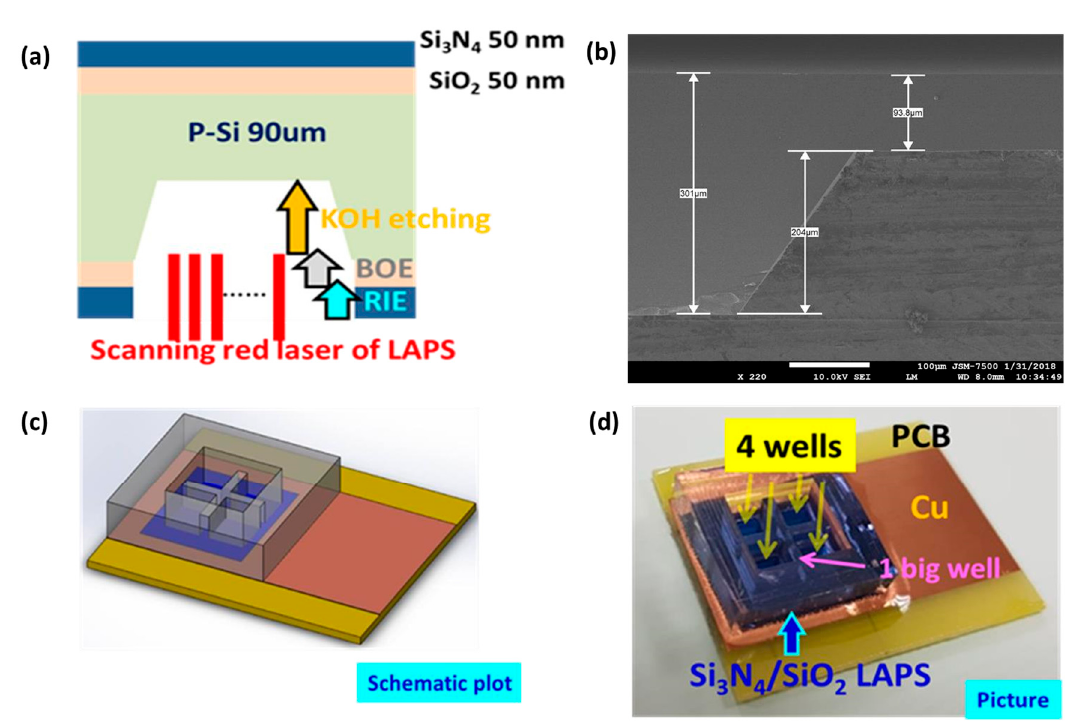
Figure 1. ( a ) Cross-sectional schematic plot, ( b ) SEM picture, ( c ) schematic 3D plot and ( d ) picture of real LAPS sample.